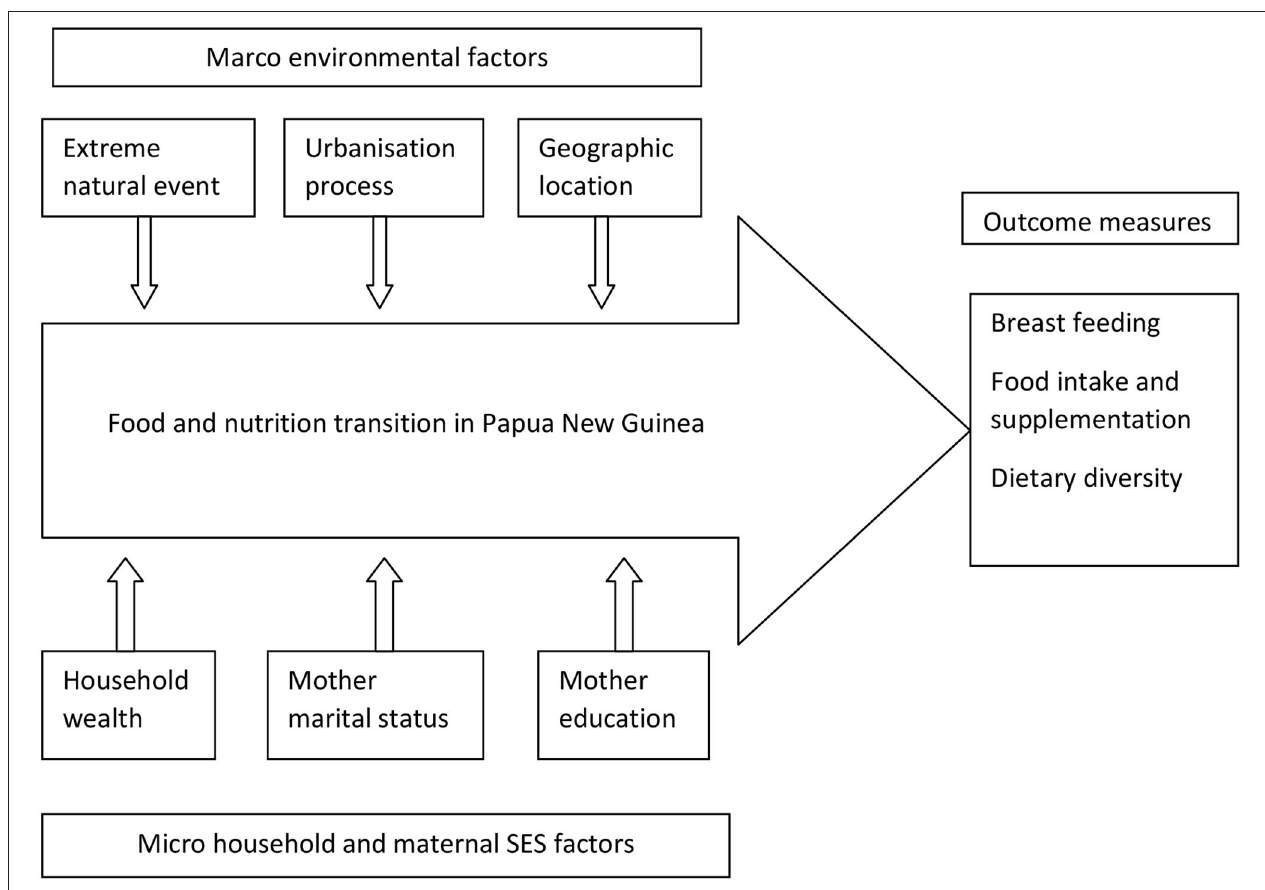
FIGURE 1 | Conceptual framework for analyzing breastfeeding, food intake, and dietary diversity among children under 5 years old in PNG, PNGIMR’s CHESS,